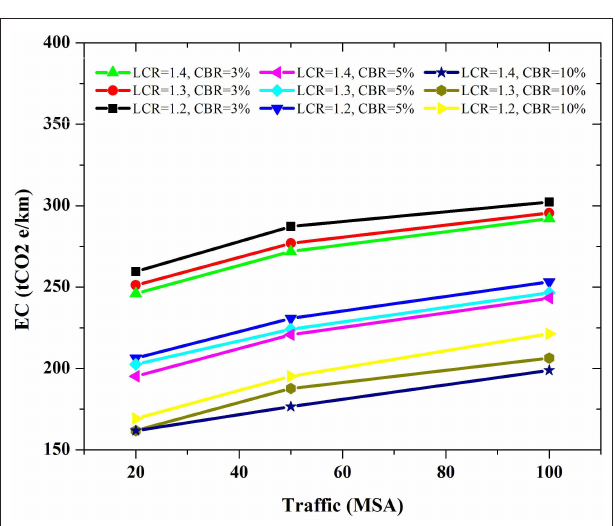
FIGURE 7 | Variation of EC values with traffic for different subgrades and LCR values of geogrid reinforced